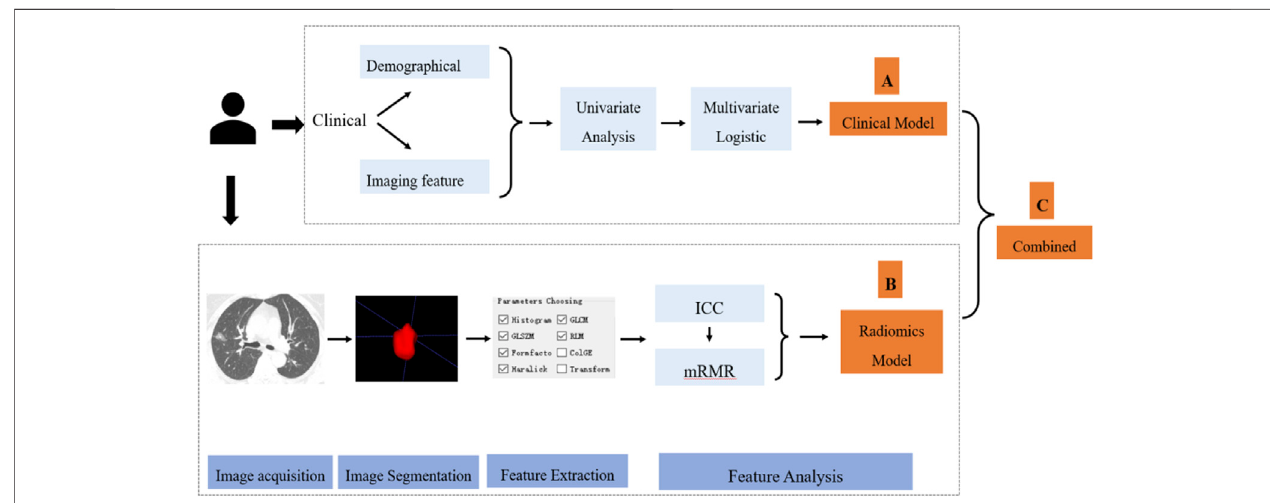
FIGURE 1 | Flowchart of clinical and radiomics feature